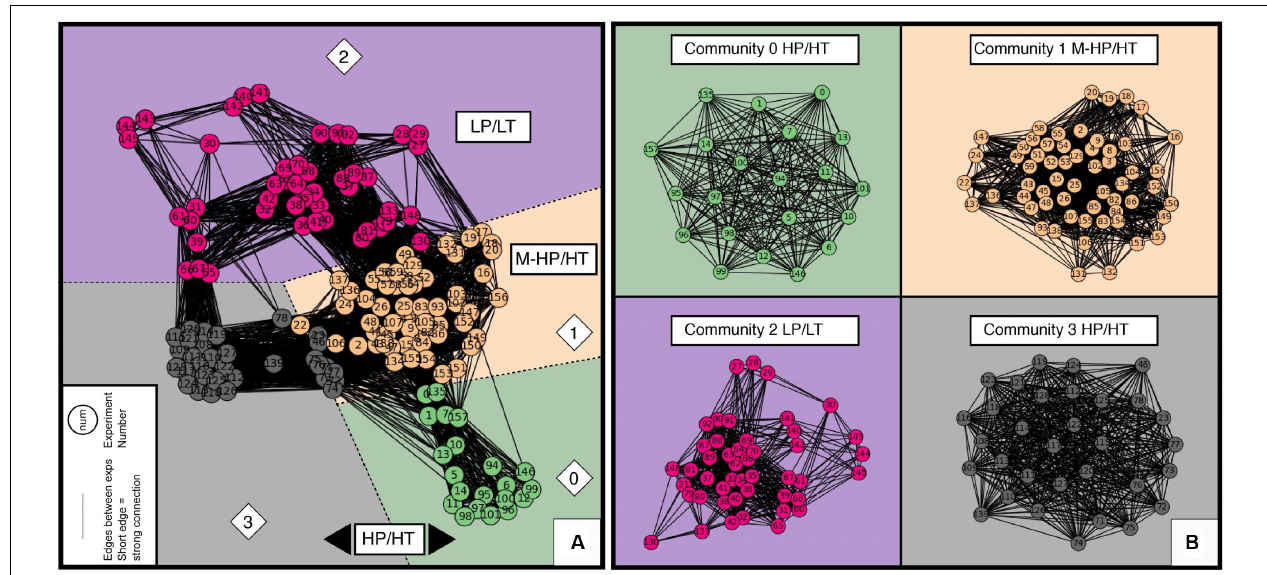
FIGURE 5 | Networks built with the cosine similarity matrix calculated from the dataset, with the four detected communities that are a snapshot of the conditions tested so far and their usual experimental protocols (community 0: HP/HT using HCOOH as a source of C and H 2 , community 1: M-HP/HT, community 2: LP/LT, community 3: HP/HT with C_ratio > 1) (see Figures 6 , 7 ). (A) The full network. Each filled circle (node) represents an experiment, which number is included and allows to back track the corresponding experiment in the database. The shorter the link (edge) between two circles, the higher the correlation between